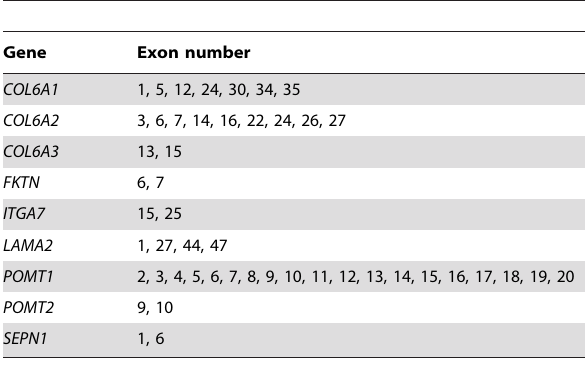
Table 3. Exons with consistently low coverage ( , 20 6 average) across all